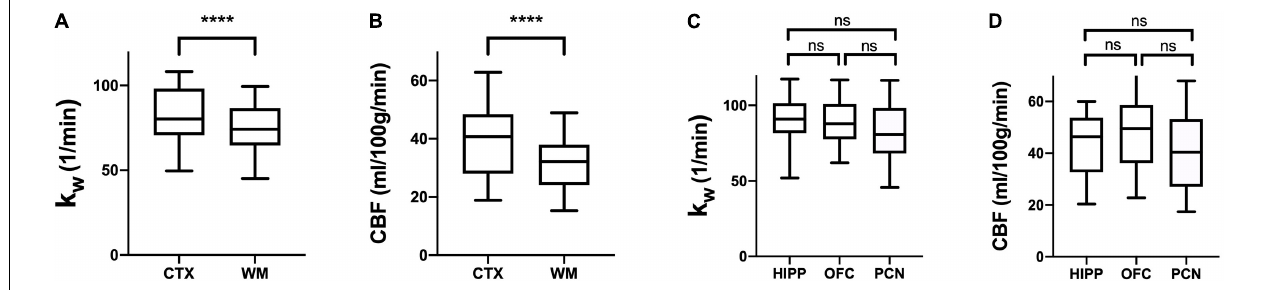
FIGURE 1 | Regional k W and CBF. Tukey box plots of k W (A,C) and CBF (B,D) values obtained in the cerebral cortex (CTX), cerebral white matter (CWM), hippocampi (HIP), orbitofrontal cortices (OFC), and precunei cortices (PCN) ( n = 30). CTX exhibited higher k W and CBF than CWM (**** indicates p < 0.0001, non-parametric Wilcoxon signed-rank test), whereas there were no significant differences between HIP, OFC, and PCN (Kruskal-Wallis test with a Dunn’s test for multiple comparisons). ns, not significant.